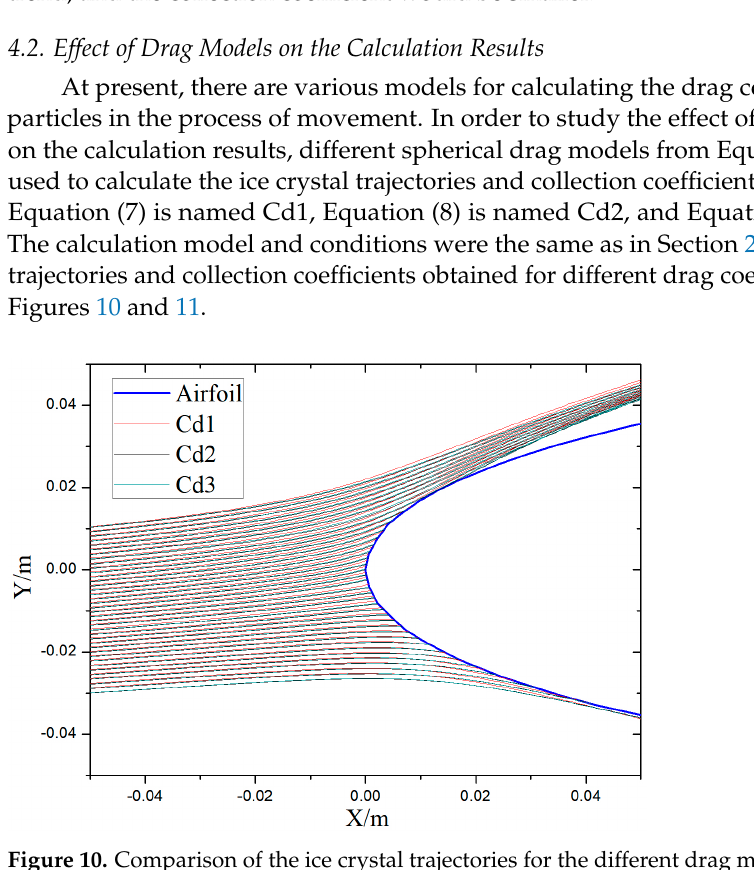
Figure 10. Comparison of the ice crystal trajectories for the di ff erent drag models.